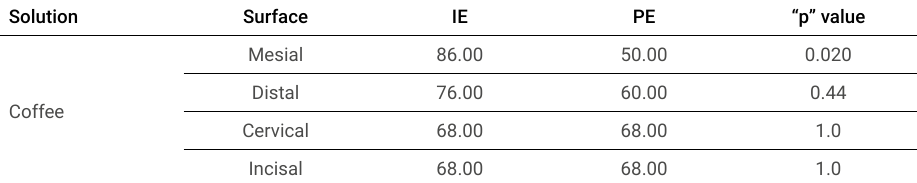
Table 3. Score comparison between IE and PE specimens on each surface (mesial, distal, cervical and incisal) immersed in coffee solution - Mann-Whitney test (n=8)